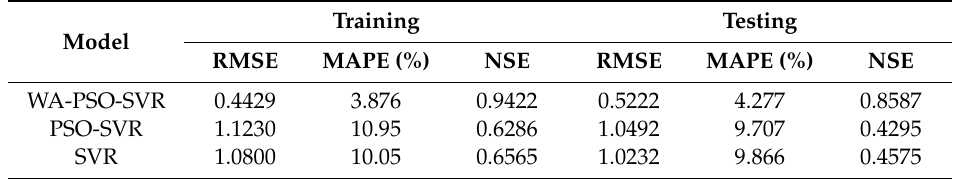
Table 7. Statistical values of monthly DO prediction in the training and testing phase.